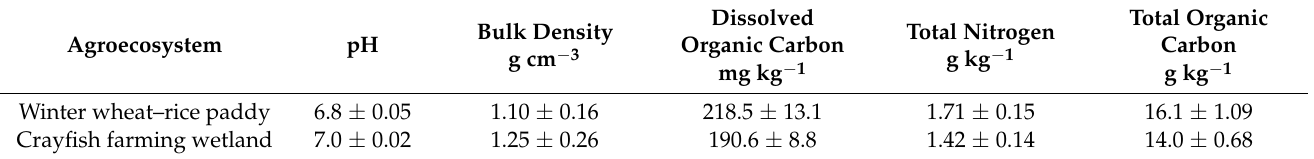
Agroecosystem pH